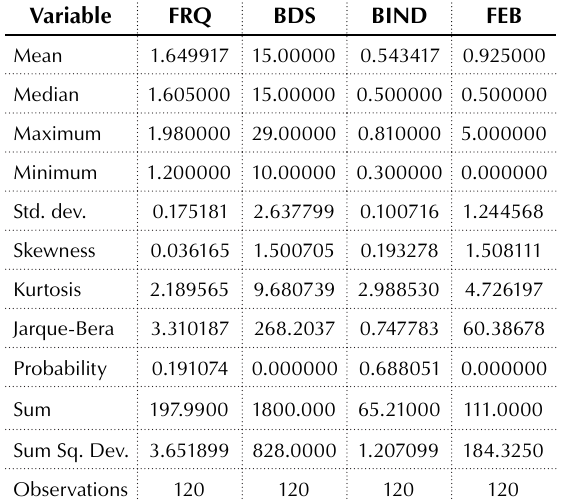
Table 1. Descriptive statistics of variables